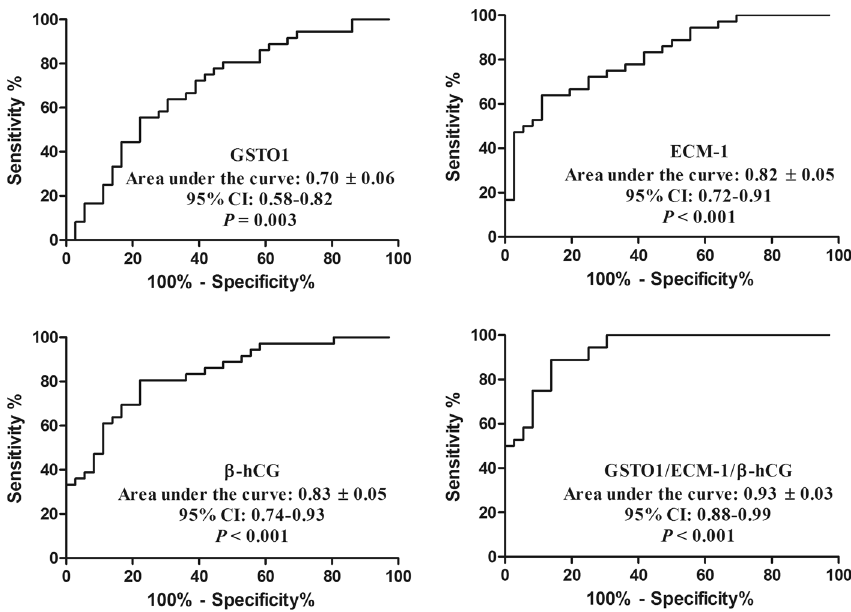
Figure 4. Receiver operating characteristic curves of GSTO1, ECM-1 and